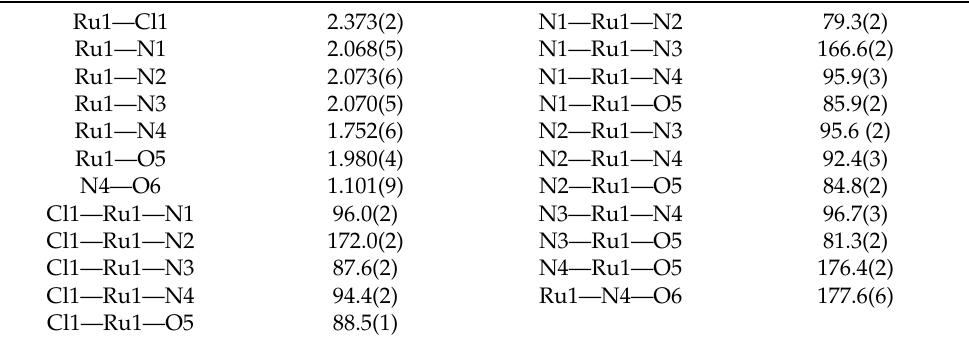
Table 2. Selected bond distances [Å] and angles [ ◦ ] for Ru-Lbpy 2